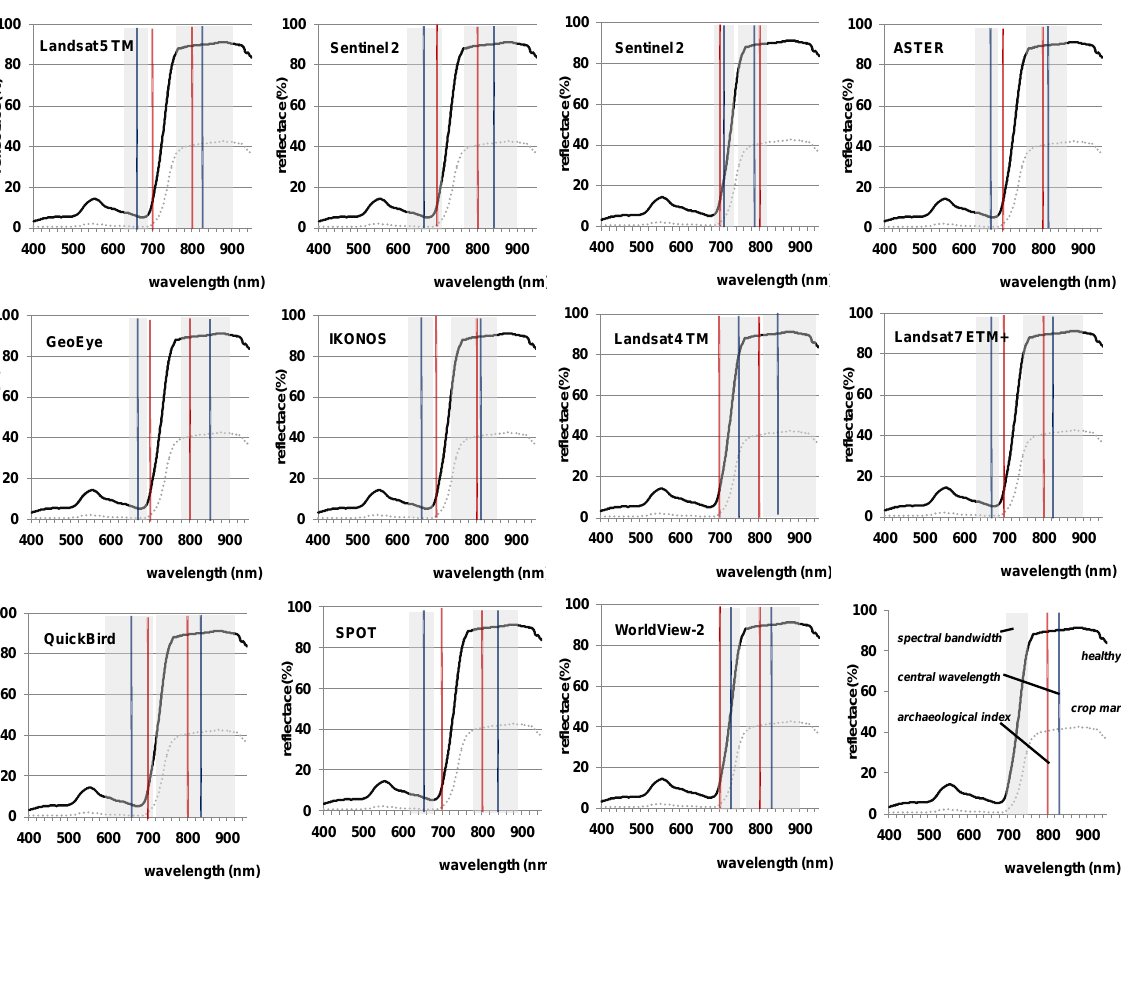
Figure 2. Spectral bandwidths of the Red–NIR for different sensors used in this study: Landsat 5 TM (Bands 3–4); Sentinel-2 (Bands 4–8); Sentinel-2 (Bands 5–7); ASTER (Bands 2–3); IKONOS (Bands 3–4); Landsat 4 TM (Bands 3–4); Landsat 7 ETM+ (Bands 3–4); QuickBird (Bands 3-4); SPOT (Bands 2–3); and WorldView-2 (Bands 5–7). Blue line indicates the central wavelength of sensor bands while red line the optimum spectral regions for the detection of crop marks (700 nm and 800